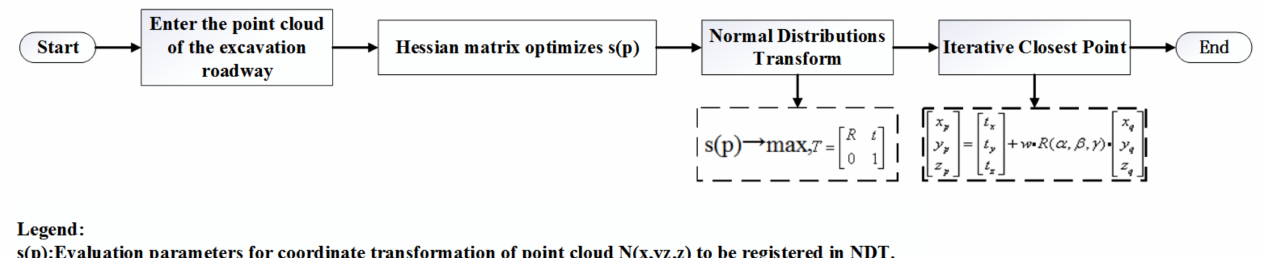
Figure 6. Flow of a traditional 3D NDT-ICP